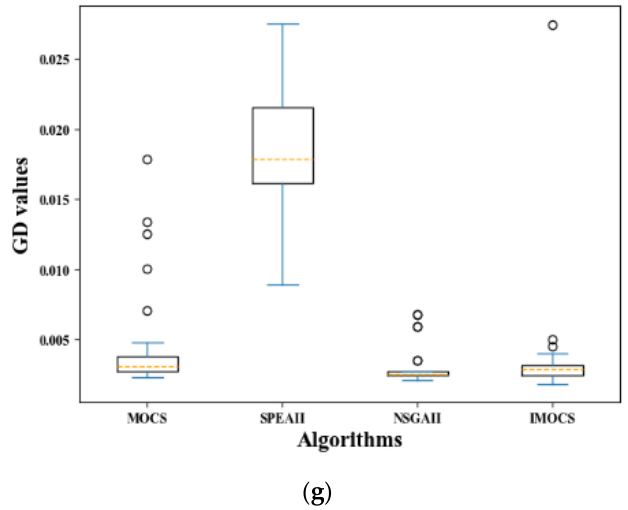
Figure 9. Boxplot of GD values achieved by different algorithms. ( a ) ZDT1, ( b ) ZDT2, ( c ) ZDT3, ( d )